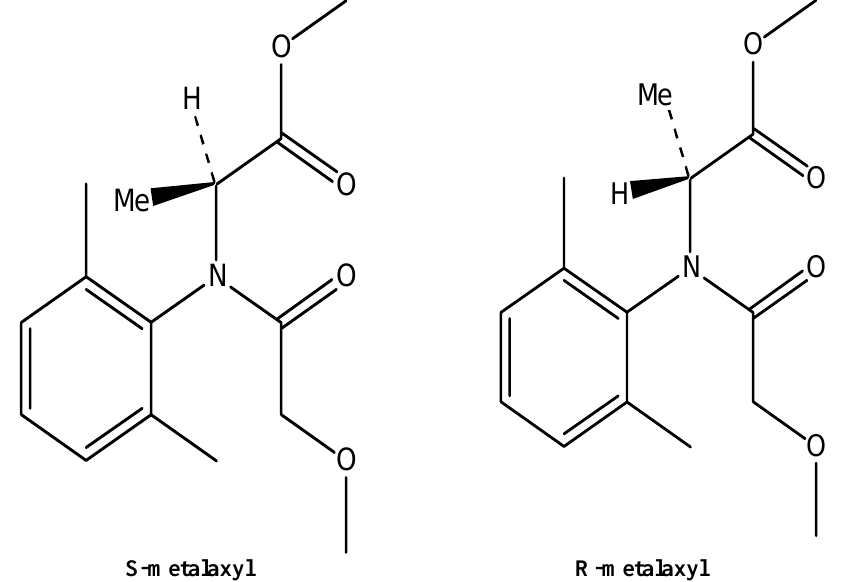
Figure 1: Structures of the two metalaxyl